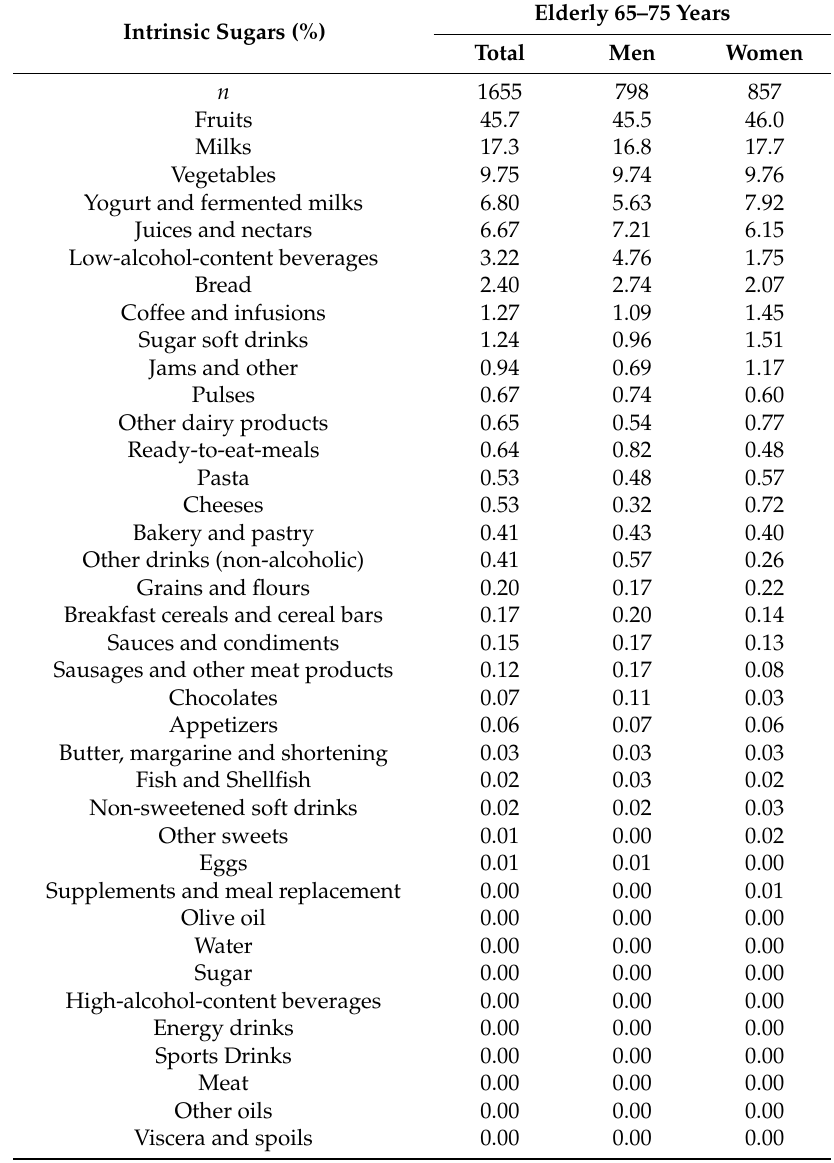
Table 10. Dietary sources of intrinsic sugars (%) from food and beverage subgroups in the ANIBES Study Spanish population aged 65–75 years: